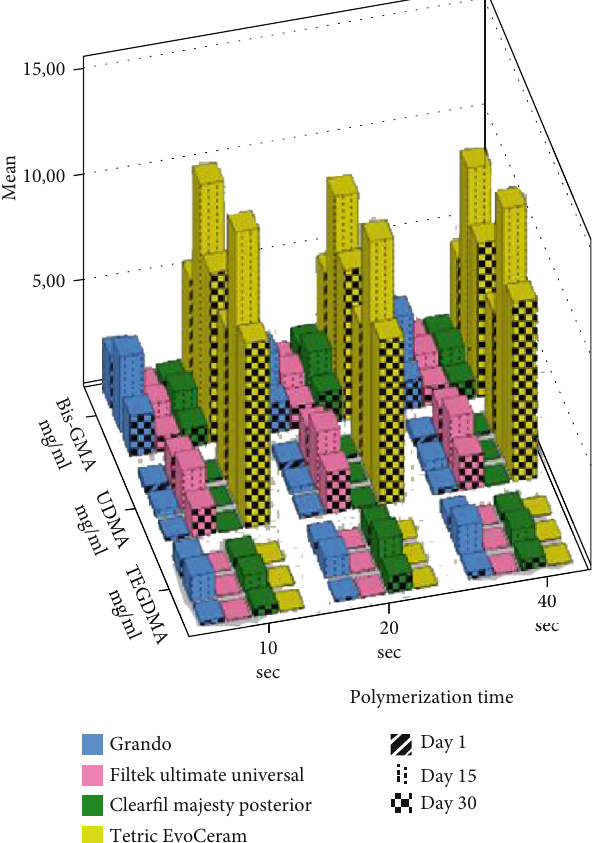
Figure 2: Residual monomer released from